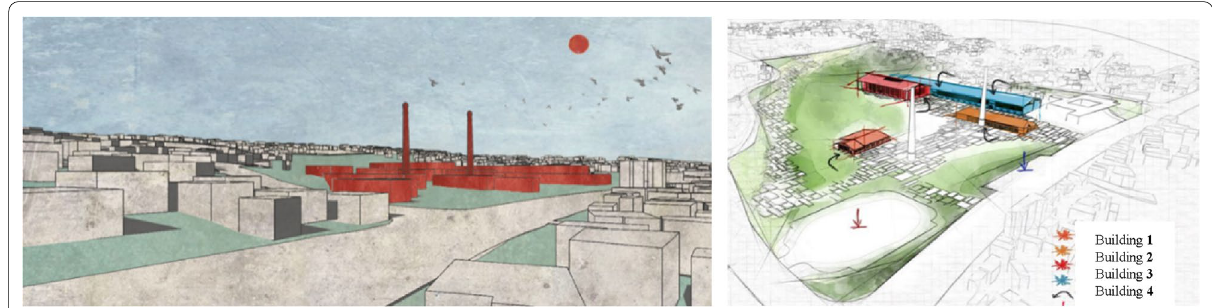
Fig. 3 Brick Factory volume: a actual state, b proposal (author: